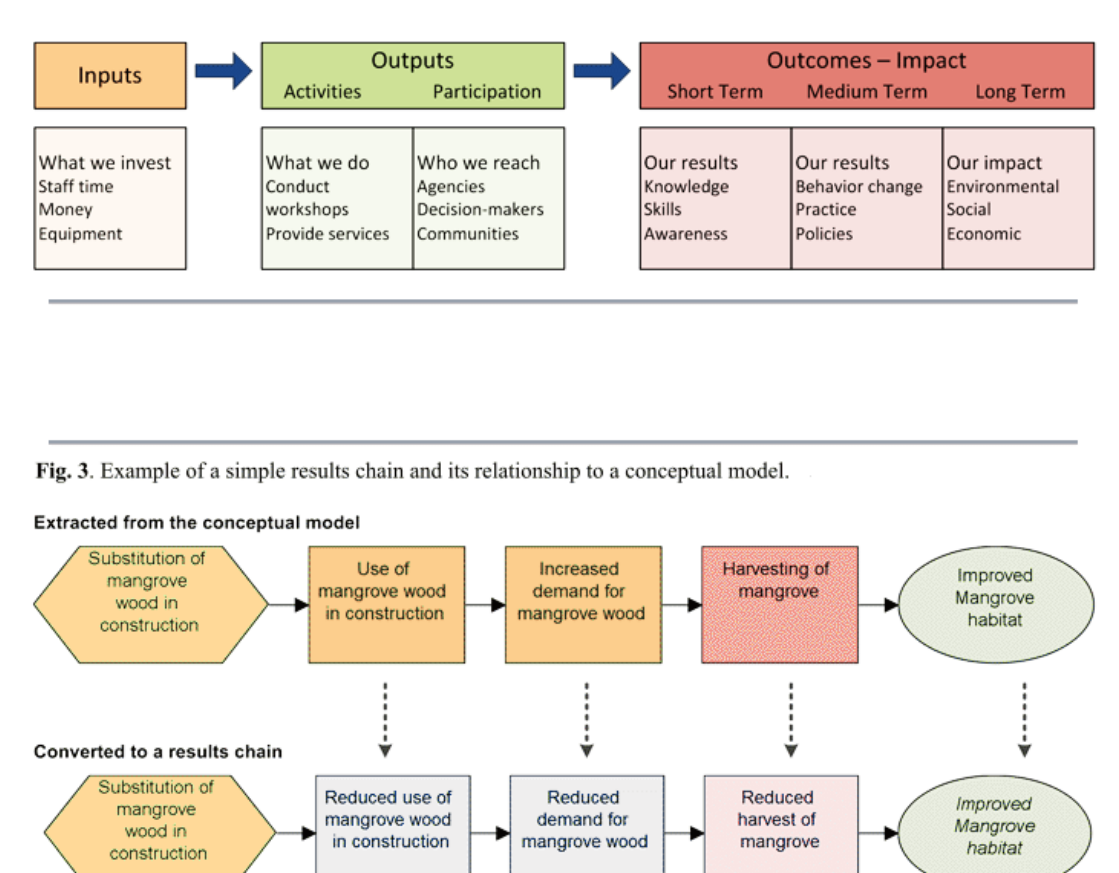
Fig. 2 . Generic logic model (Source: University of Wisconsin Extension Program Development and Evaluation).